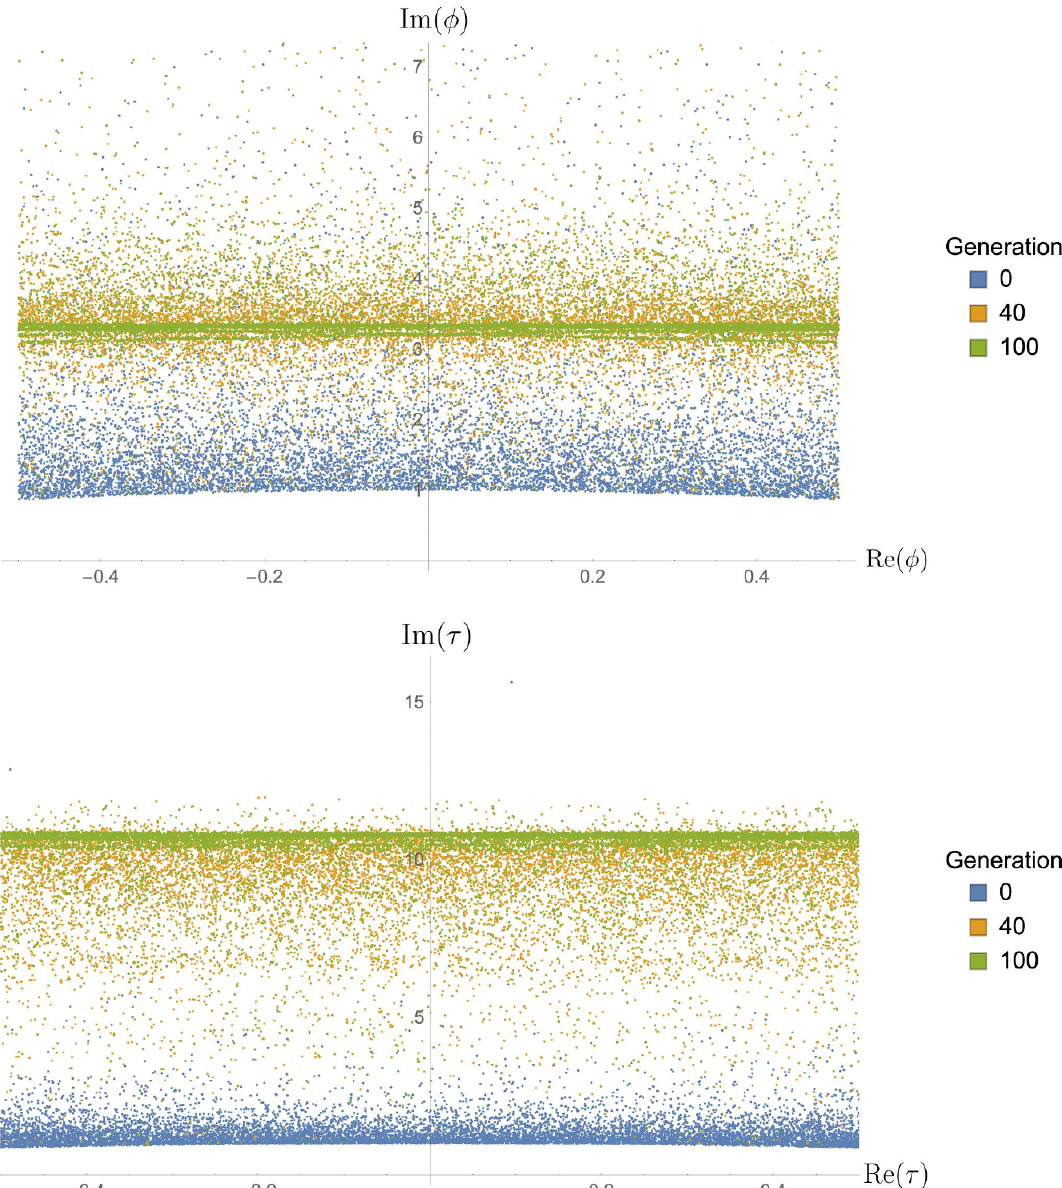
Figure 8 . Evolution of the distribution of (cid:30) (top) and (cid:28) (bottom) for three